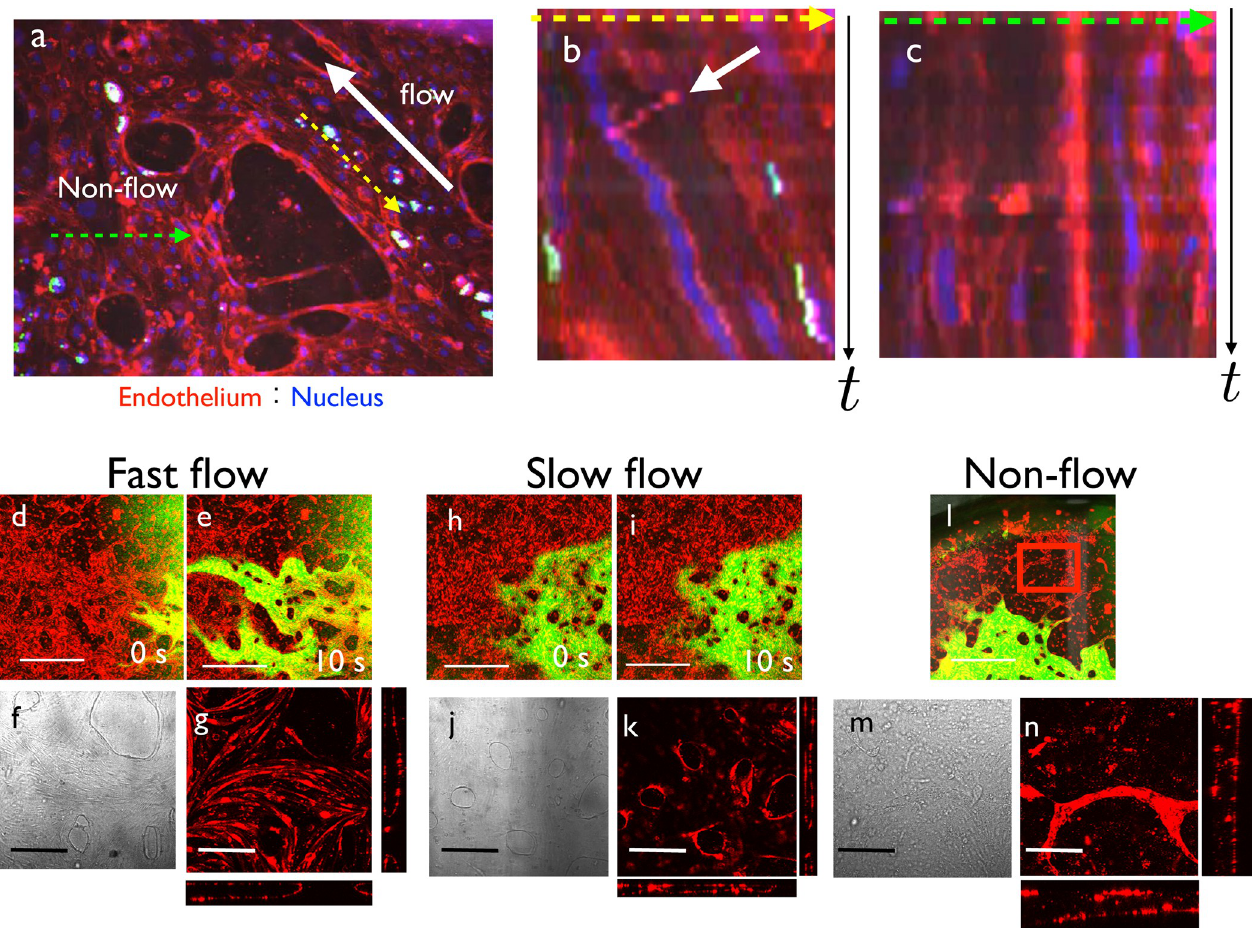
Fig 2. Flow-induced collective cell migration and cell shape changes. (a) Initial shape of the vascular network. HUVECs were stained with UEA1 and nuclei were stained with Hoechst 33342. There was a flow-positive region (yellow-dashed line) and non-flow region (green-dashed line). Direction of flow is indicated by a white allow. (b) Kymograph of the yellow-dashed line region. Horizontal direction represents space, and vertical direction represents time. Collective movement toward upstream of the flow was observed. White arrow indicates the flow of cell debris. (c) Kymograph of the green-dashed line region. Cell movement was random. (d–n) Cell shape changes induced by flow: (d, e) Fast flow. When FITC dextran was perfused, the vessel regions near the inlet or outlet showed fast flow. (f) Brightfield view of the fast flow region. Endothelial cells became shaped as spindles aligned parallel to the flow direction. (g) Fluorescence view of the fast flow region. At the floor of the lumen, we observed spindle-shaped cells parallel to the flow direction. (h, i) Slow flow. When FITC dextran was perfused, the vessel regions far from the inlet or outlet showed slow flow. (j) Brightfield view and (k) confocal view of the slow flow region. Endothelial cells did not show any polarity. (l) Low magnification view of the non-flow region. (m) Brightfield view and (n) confocal view of the non-flow region. Vasculatures were disconnected and became thin endothelial cysts with cell debris inside. Scale bars: 1 mm (d, e, h, i, l); 200 μ m (f, g, j, k, m, n).